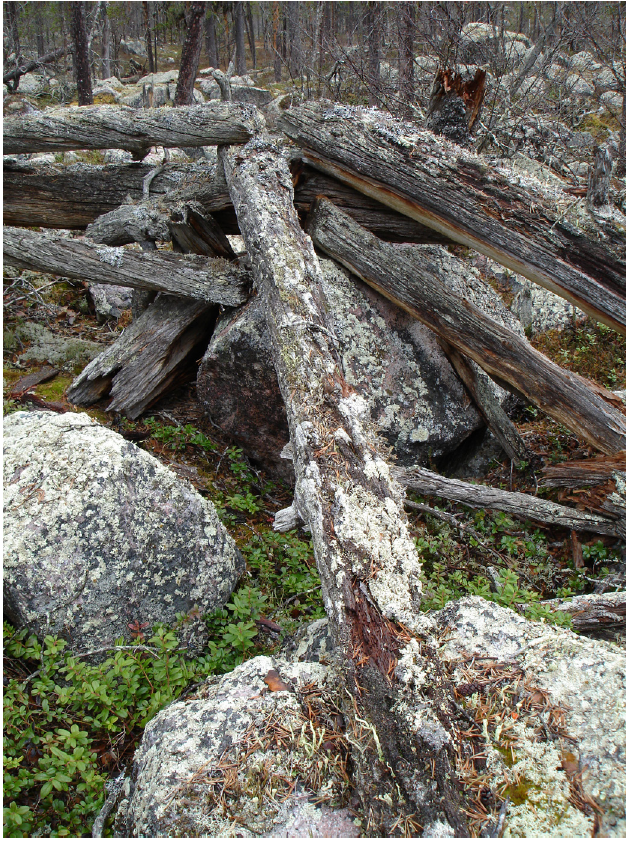
Figure 7. A stabilizer, made from a trunk inserted at a right angle to one of the